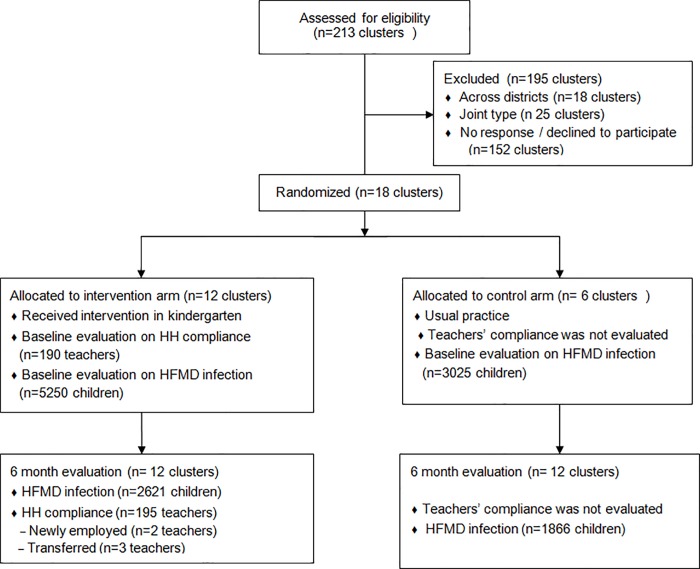
Flow diagram for cluster randomized trial evaluating the effect of a hand hygiene intervention on self-reported hand hygiene (HH) compliance of kindergarten teachers to decrease hand, foot and mouth disease (HFMD) in Baoan and Nanshan district, Shenzhen.Note: This sub study of the trial focuses on evaluating HH compliance of kindergarten teachers.